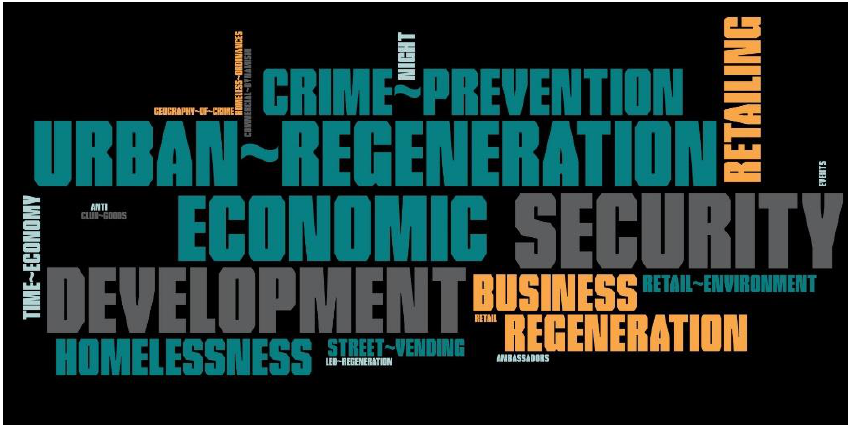
Figure 8. Word cloud, extracted from keywords that fit in dimension “Activities/Axis of intervention”.